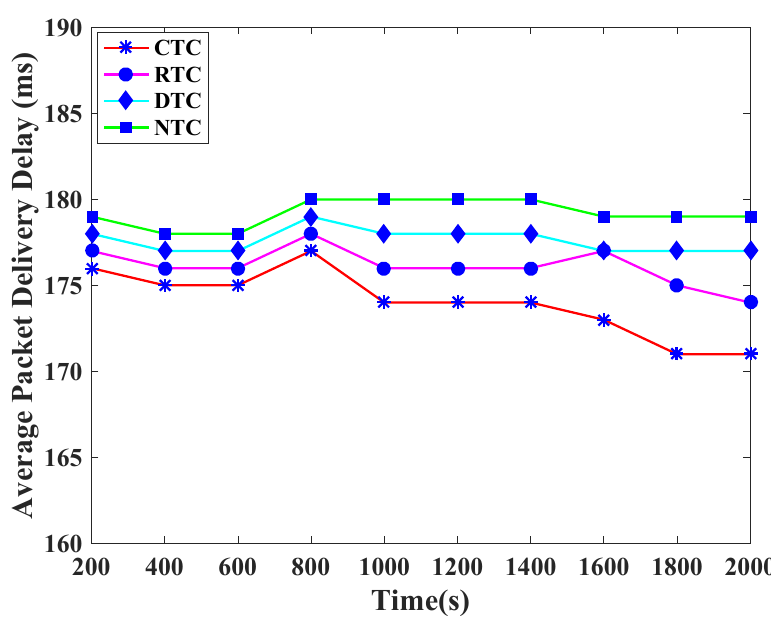
Figure 7. Packet delivery delay versus time in Seconds.